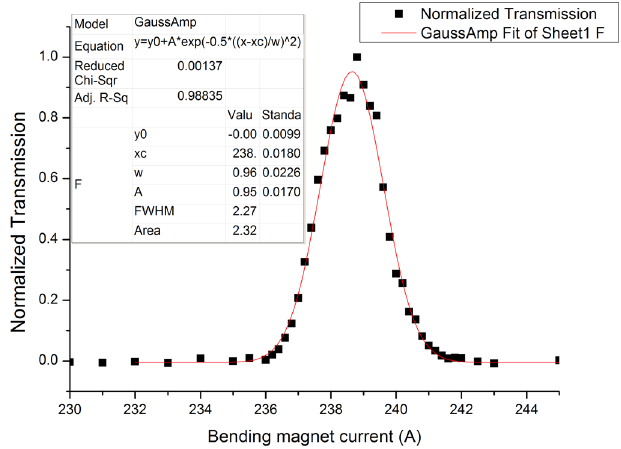
FIG. 11. Beam energy spread of the RFQ.